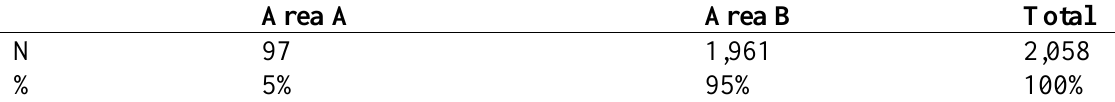
Table 2. Assemblage composition classified by